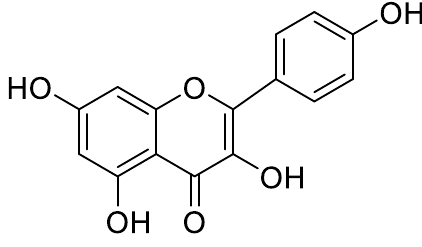
Figure 8. Kaempferol identified in Stachys cretica.